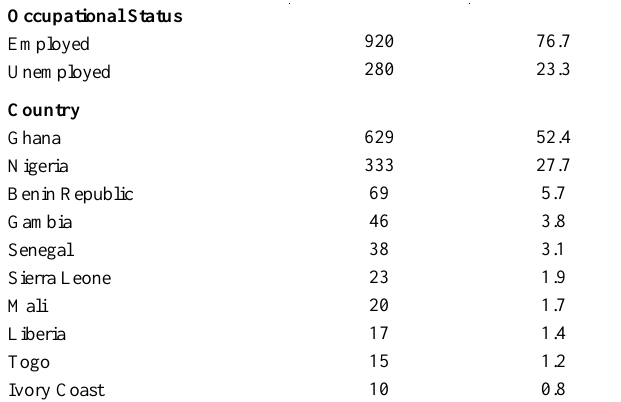
Table 1 represent the socio demographic characteristic of respondents. A total of 1200 people responded, 55.0% (660) were male while the rest 45.0% ( 540) were females. The age distribution was made up of the following: 18-20